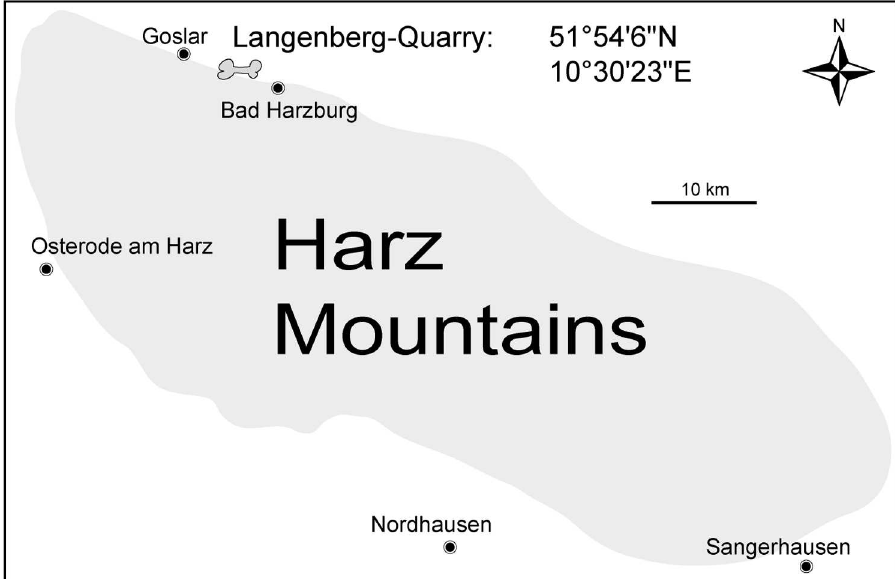
Fig 1. Location of the Langenberg locality in